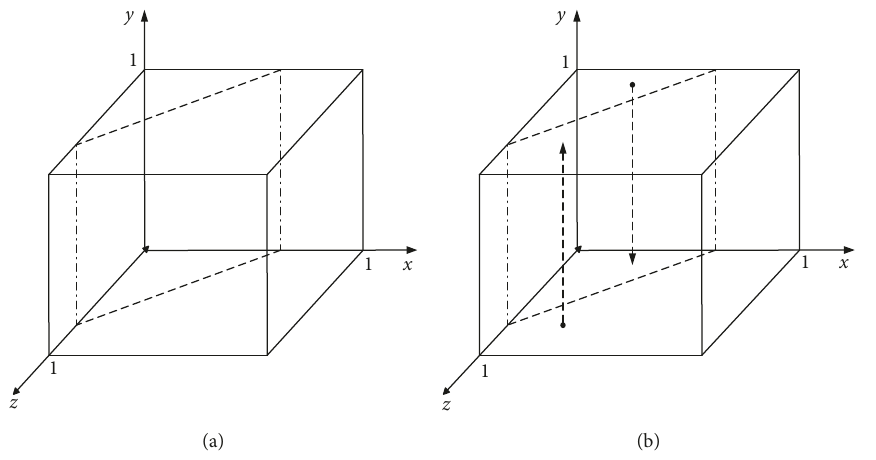
Figure 2: Replicator dynamic phase diagram of external investors. (a) z